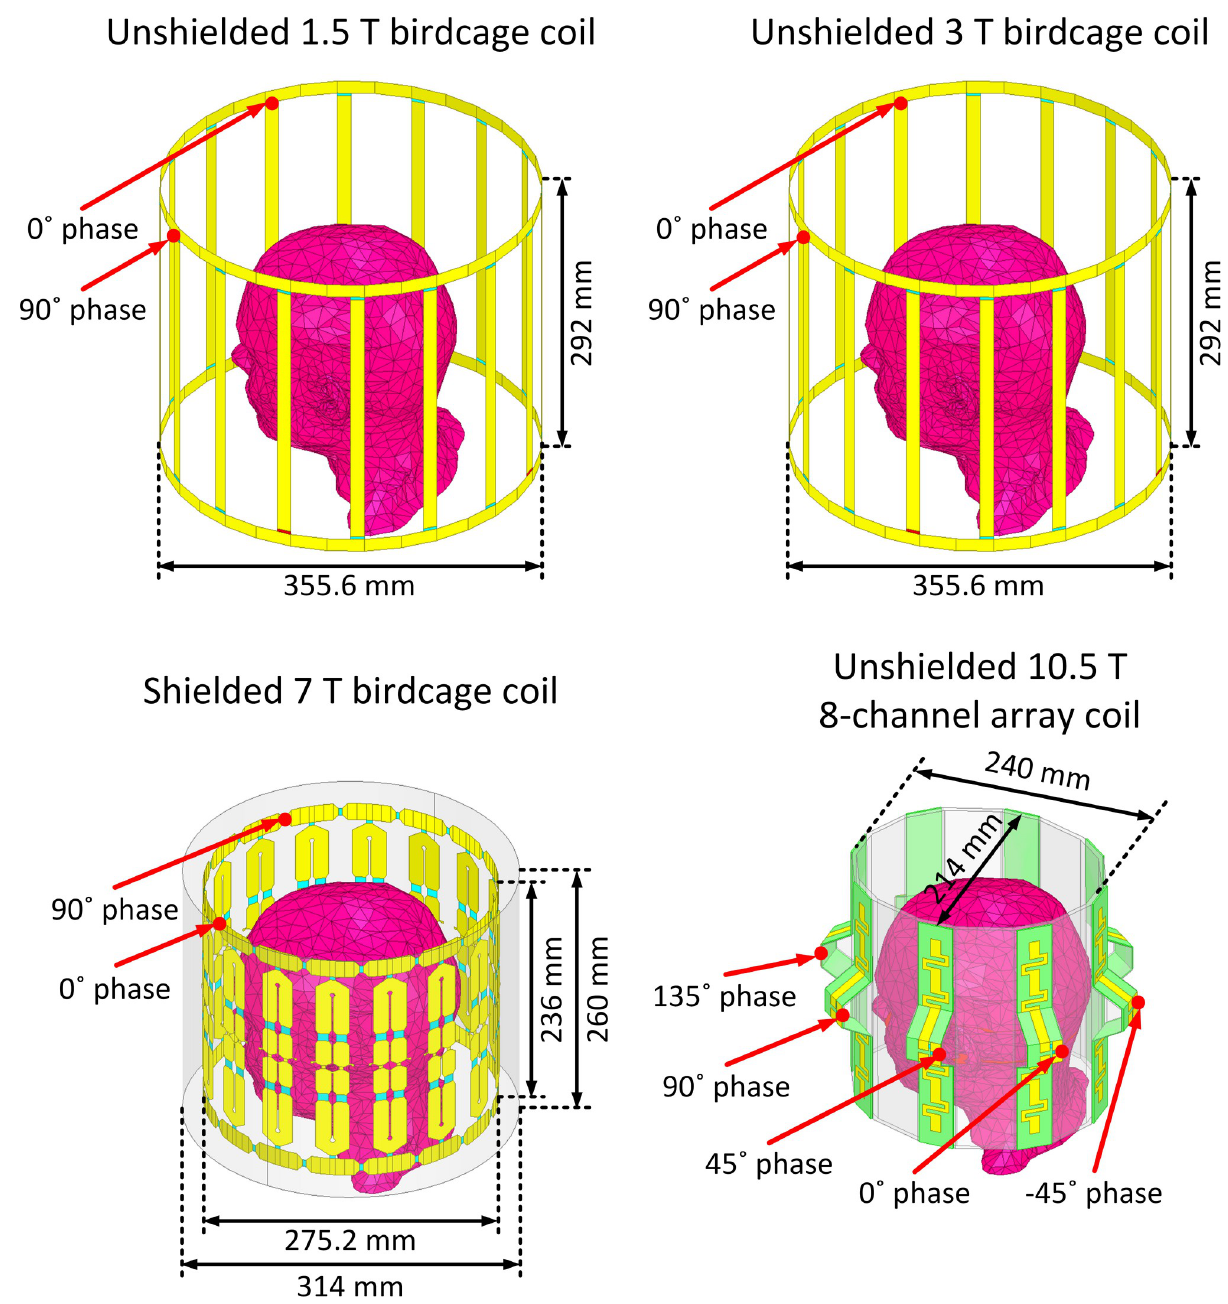
Fig 1. Numerical models of a 1.5 T 16-rung low-pass birdcage coil tuned at 64 MHz, a 3 T 16-rung low-pass birdcage coil tuned at 127 MHz, a 7 T 16-rung hybrid birdcage coil tuned at 297 MHz, and a 10.5 T 8-channel bumped dipole array tuned at 447 MHz all loaded with a homogeneous human head model with no implant. The geometrical dimensions of the coils were the same as the coils reported in literature